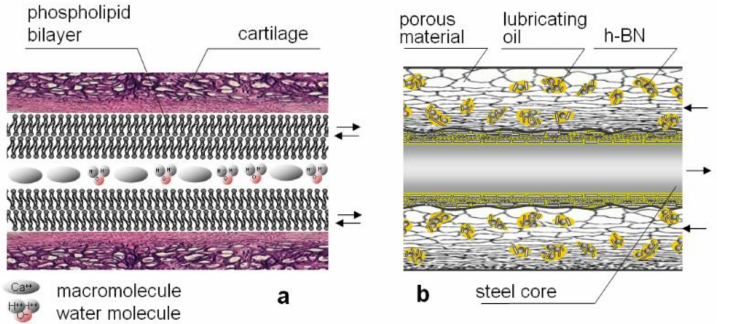
Figure 1. Model of lamellar lubrication in ( a )—natural (biological) bearing and ( b )—oil-colored porous bearings with the addition of h-BN